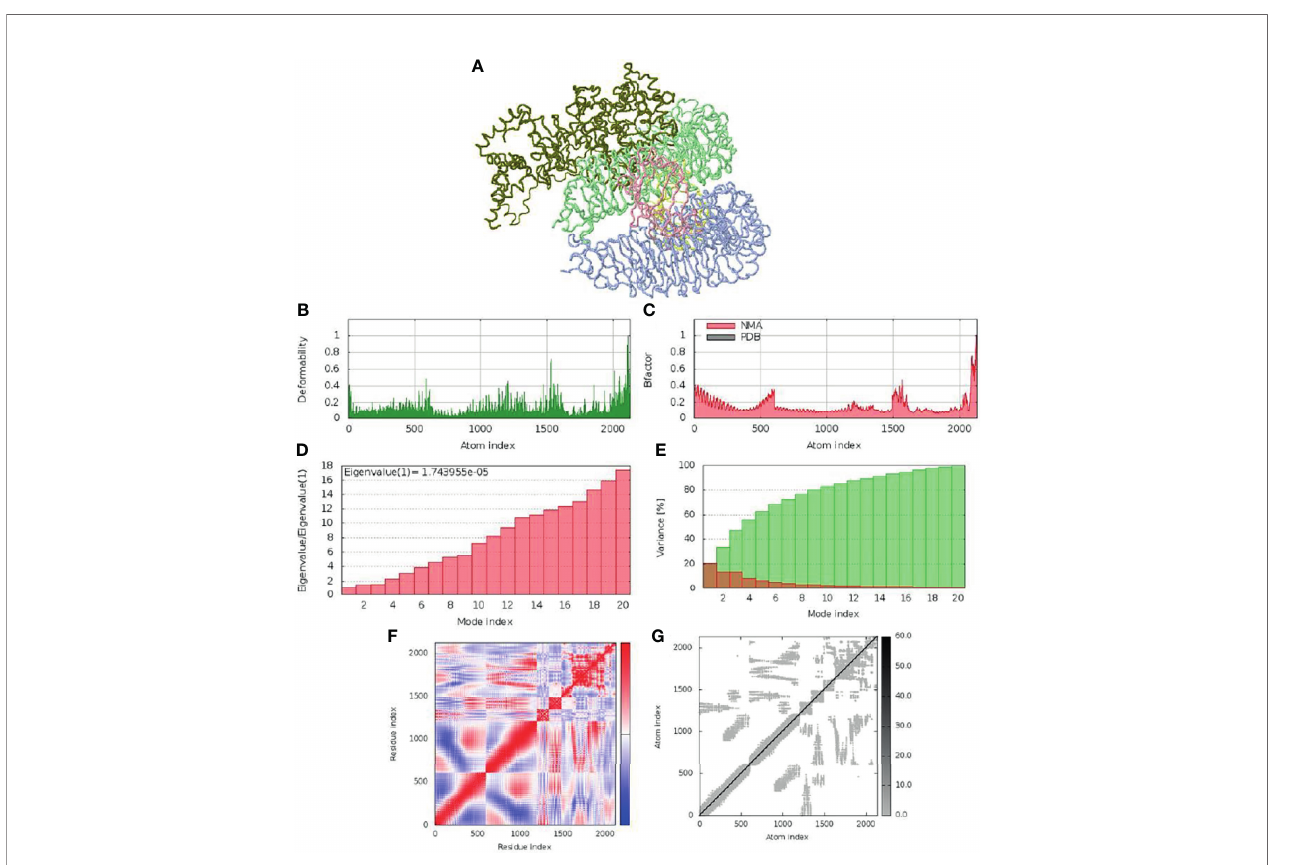
FIGURE 6 | Molecular dynamic simulation of SMV4 and TLR4 docked complex. (A) NMA mobility. (B) deformability. (C) B-Factor. (D) eigenvalue. (E) variance (red: individual variance, green: cumulative variance). (F) co-variance map (correlated in red, uncorrelated in white, and anti-correlated in blue). (G) elastic network.